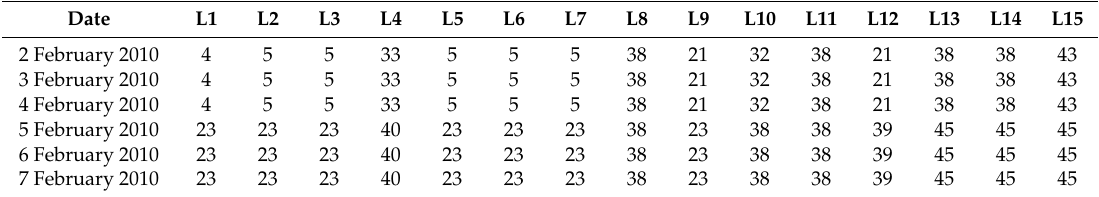
Table 2. Extract of H eq _ avg (cm) values.